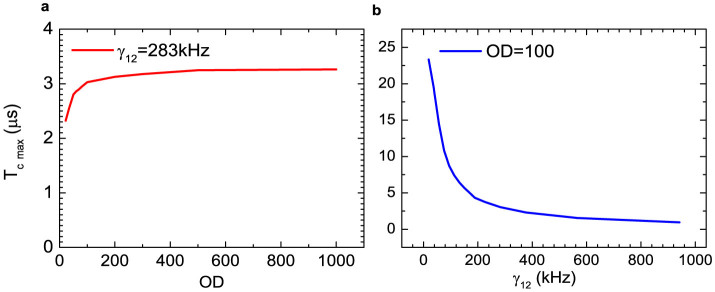
Coherence time limit.(a), Tc limits as a function of OD, with γ12
= 0.015γ13 = 283 kHz. (b), Tc
limits as a function of γ12, with OD = 100.